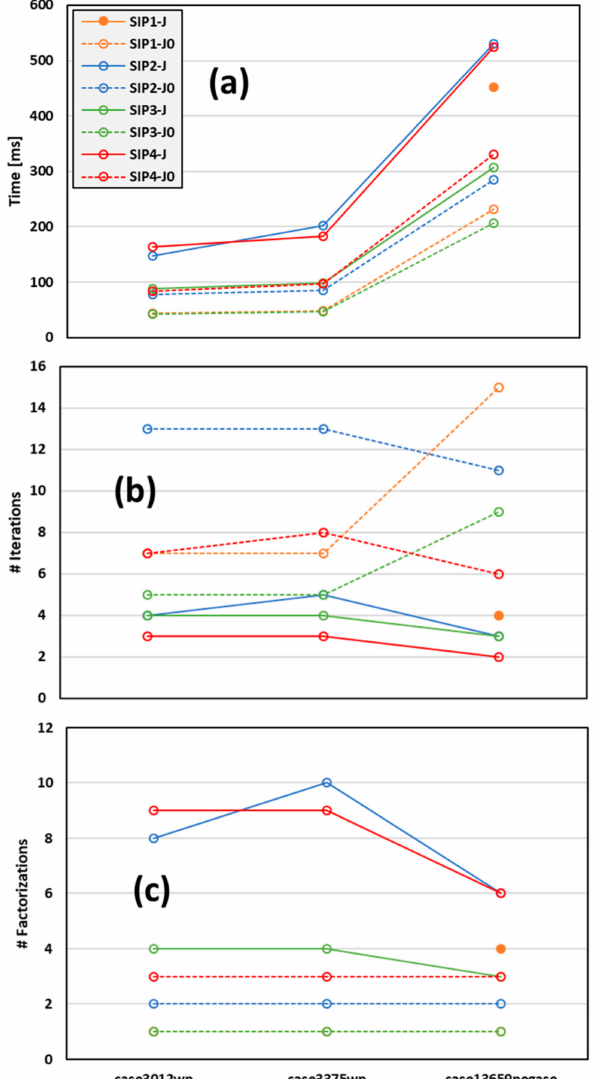
Figure 10. Comparison of the results obtained in ill-conditioned systems. ( a ) Execution time (ms), ( b ) total iterations number, and ( c ) total factorizations. S -parameters have been tuned as all studied techniques employed the least number of iterations.